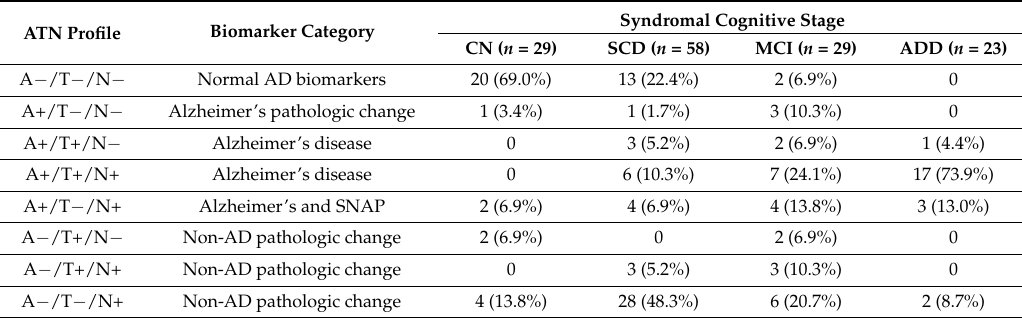
Table 6. ATN classification in regard to the biomarker profile and cognitive stage among participants with cerebrospinal fluid (CSF) AD biomarker